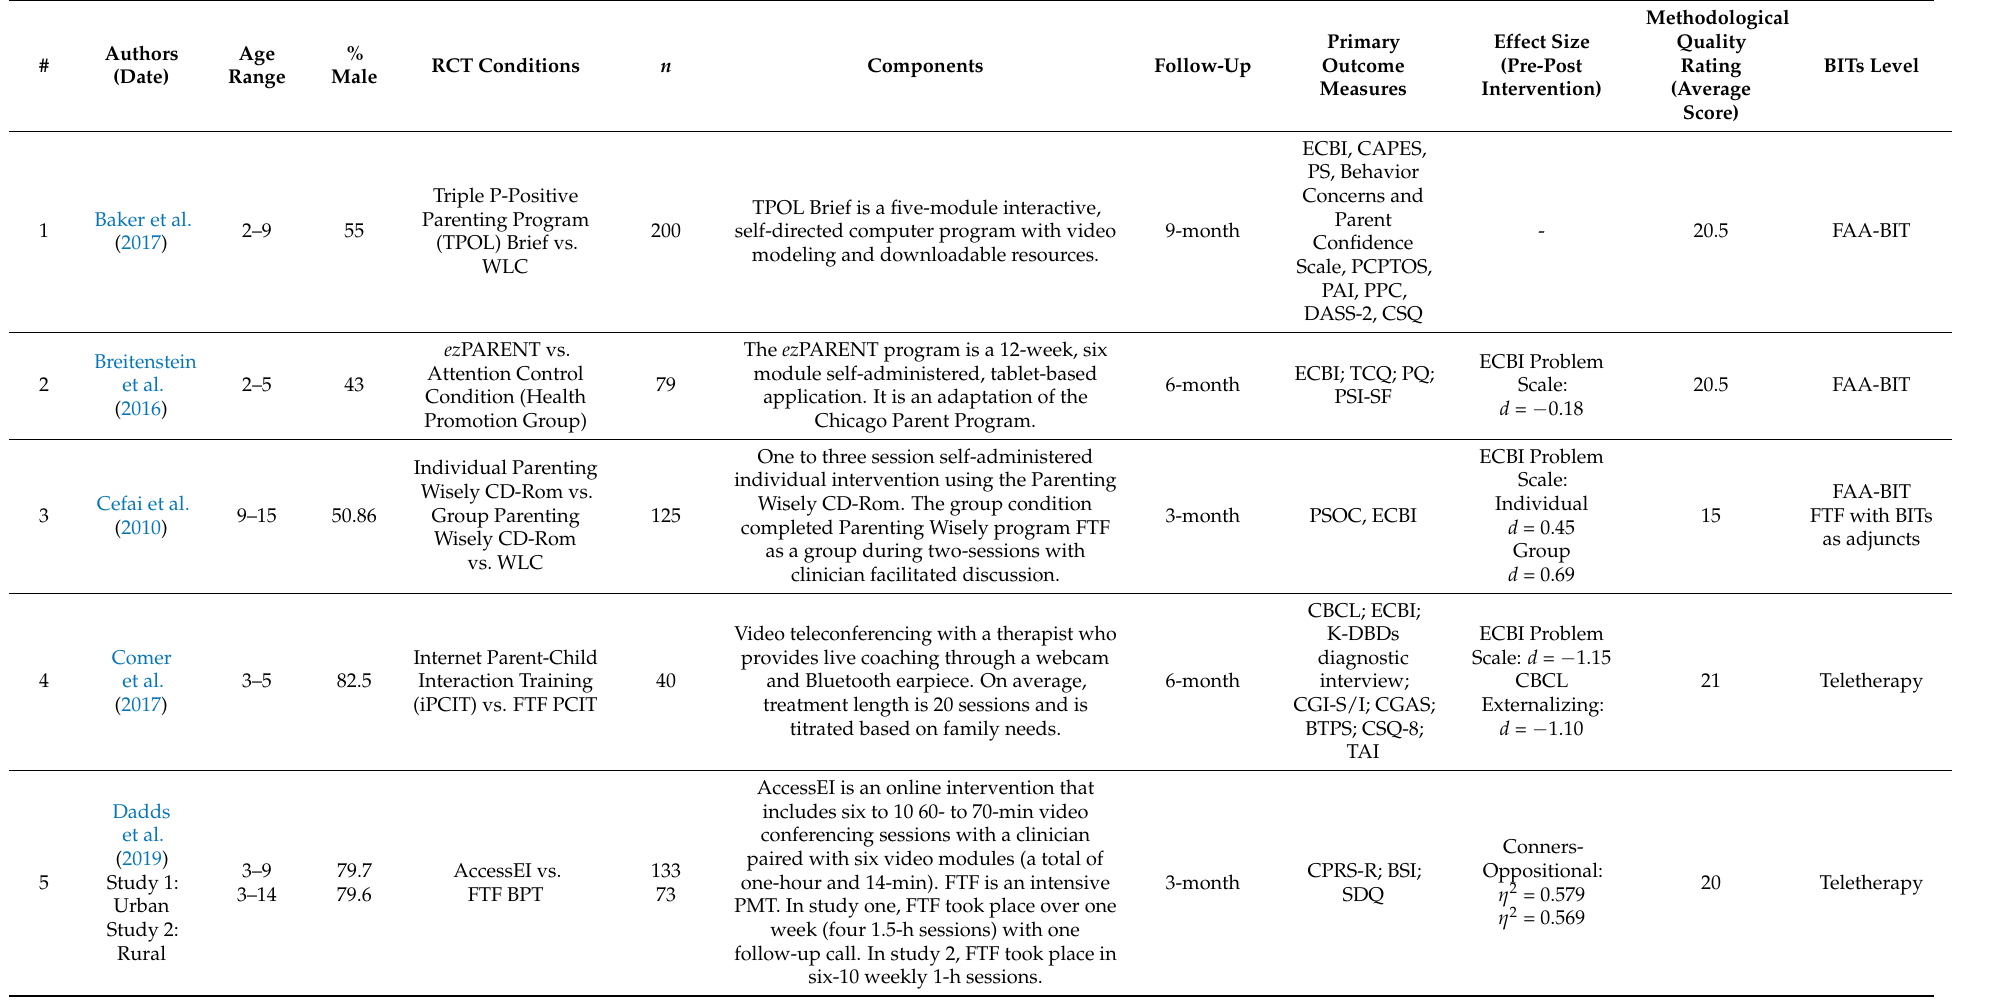
Table 1. Selected Studies for Behavioral Parent Training for Youth With Externalizing Behavioral